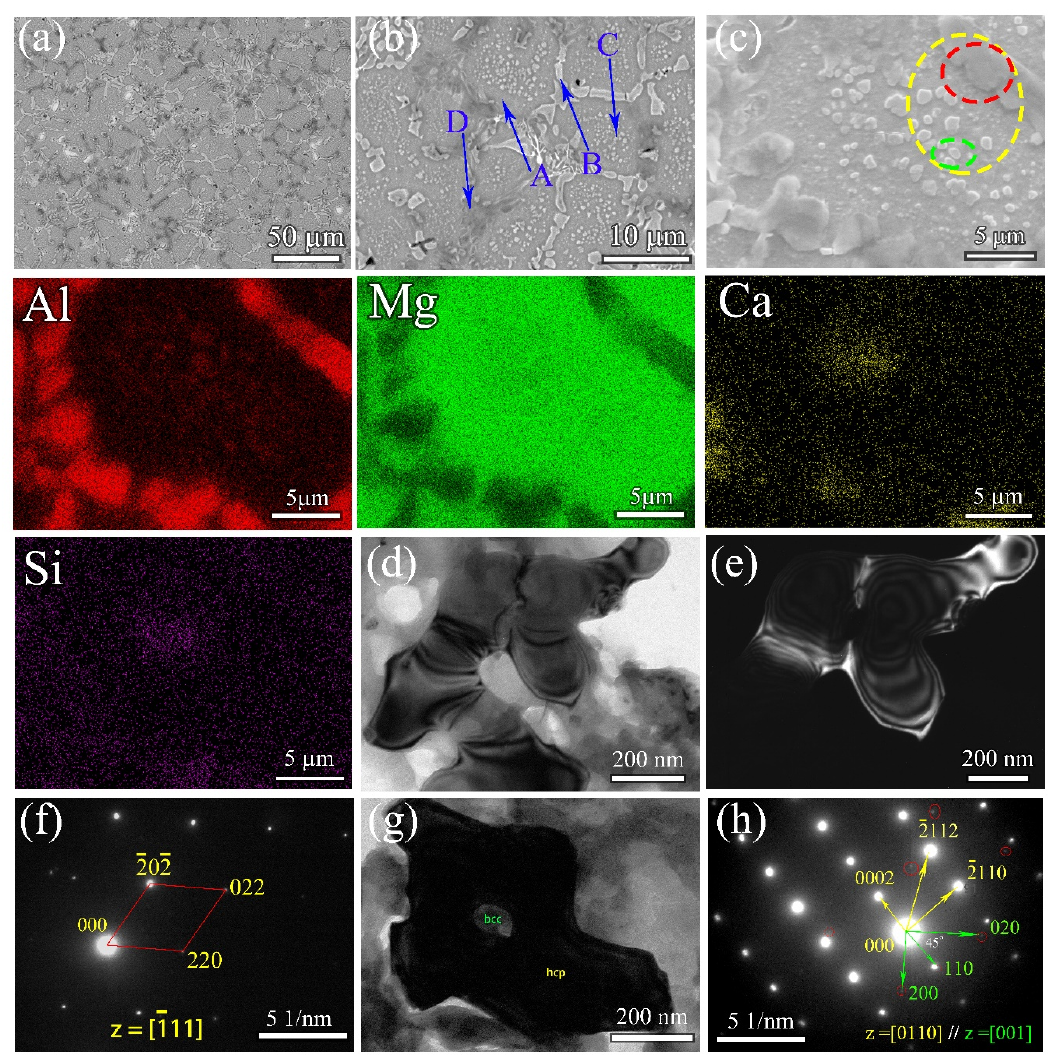
Figure 5. Microstructures of Al 15 Li 35 Mg 48 Ca 1 Si 1 ULW-CCA. ( a – c ) are BSE images (from low to high magnification); “Al”, “Mg”, “Ca” and “Si” are the EDS mapping of ( c ); ( d ) The bright-field image (BF) of red circled phase in ( c ); ( e ) The dark-field (DF) image of the red circled phase in ( c ); ( f ) The selected area diffraction pattern of ( e ). ( g ) The bright-field (BF) for submicron particle marked by green circle region in ( c ). ( h )The selected area diffraction patterns of dark area in ( g ).